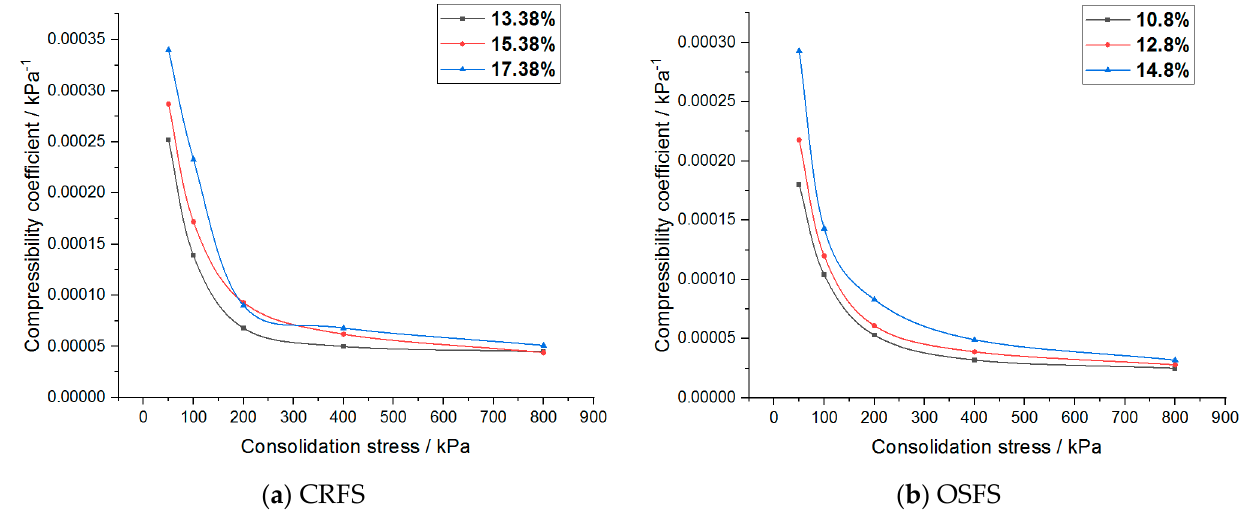
Figure 12. Compression coefficient of modified soil with different water